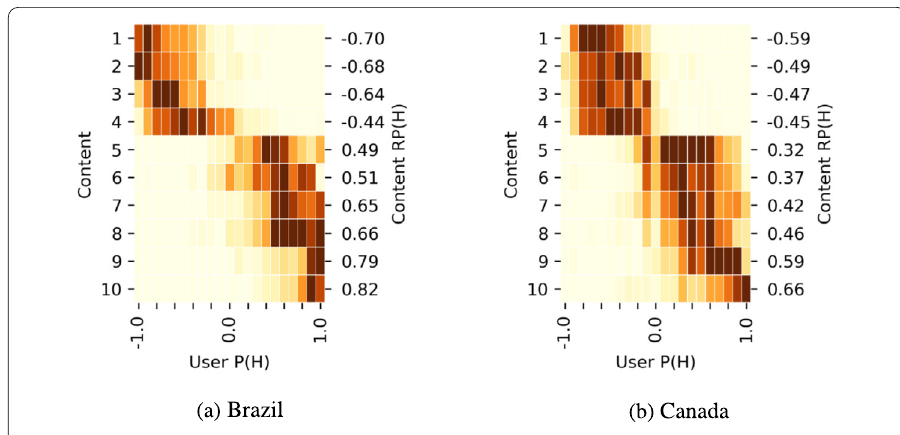
Figure 10 User engagement with news content - see Table 4 for data references